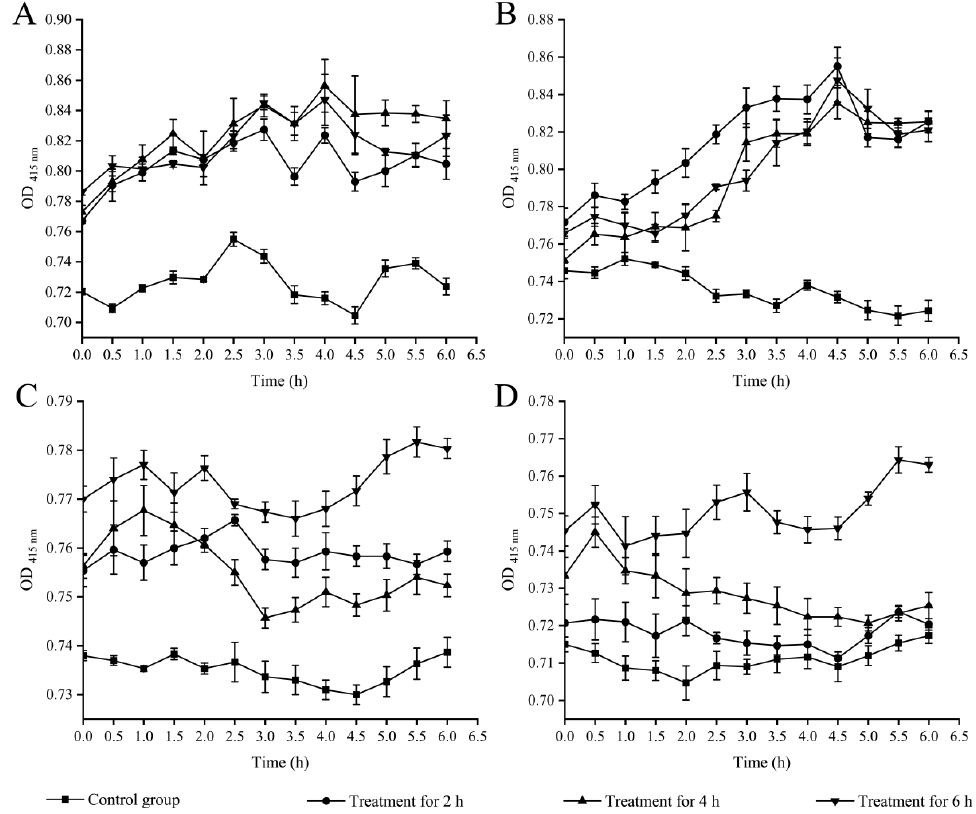
Figure 3. Effects of Fragment 1 (1 × MIC) from P. kleiniana Wight et Arn on the bacterial inner cell membrane permeability. ( A – D ) V. parahaemolyticus B5-29, V. parahaemolyticus ATCC17802, S. aureus ATCC25923, and S. aureus ATCC8095, respectively. The treatment groups were overall significantly different from the control groups ( p < 0.05), except the S. aureus ATCC8095 group treated for 2 h (D).